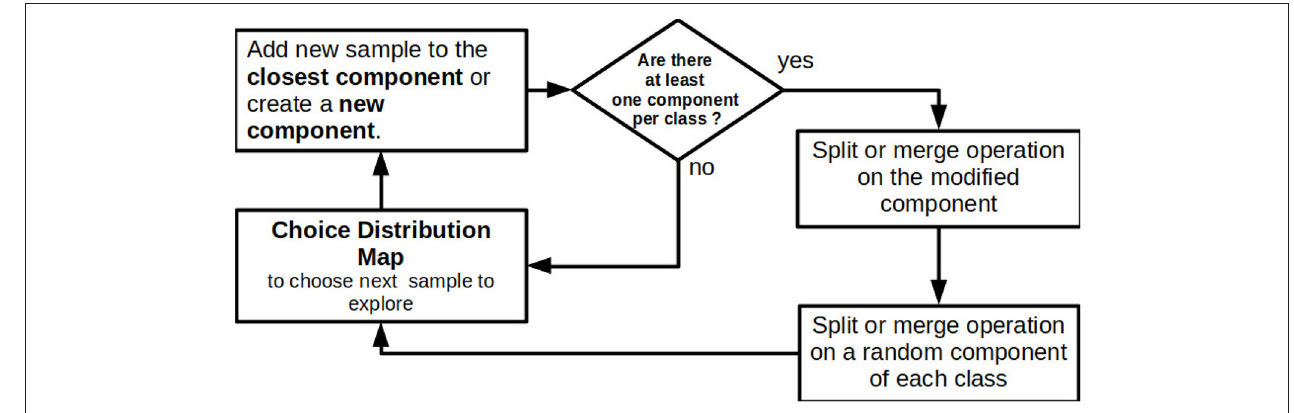
FIGURE 3 | Schema of the training algorithm of